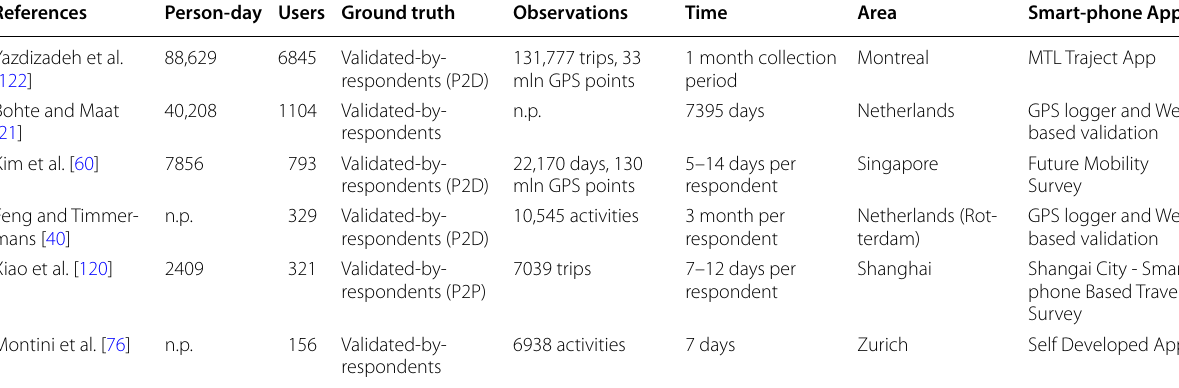
Table 5 Dataset ranked by number of users, for purpose imputation